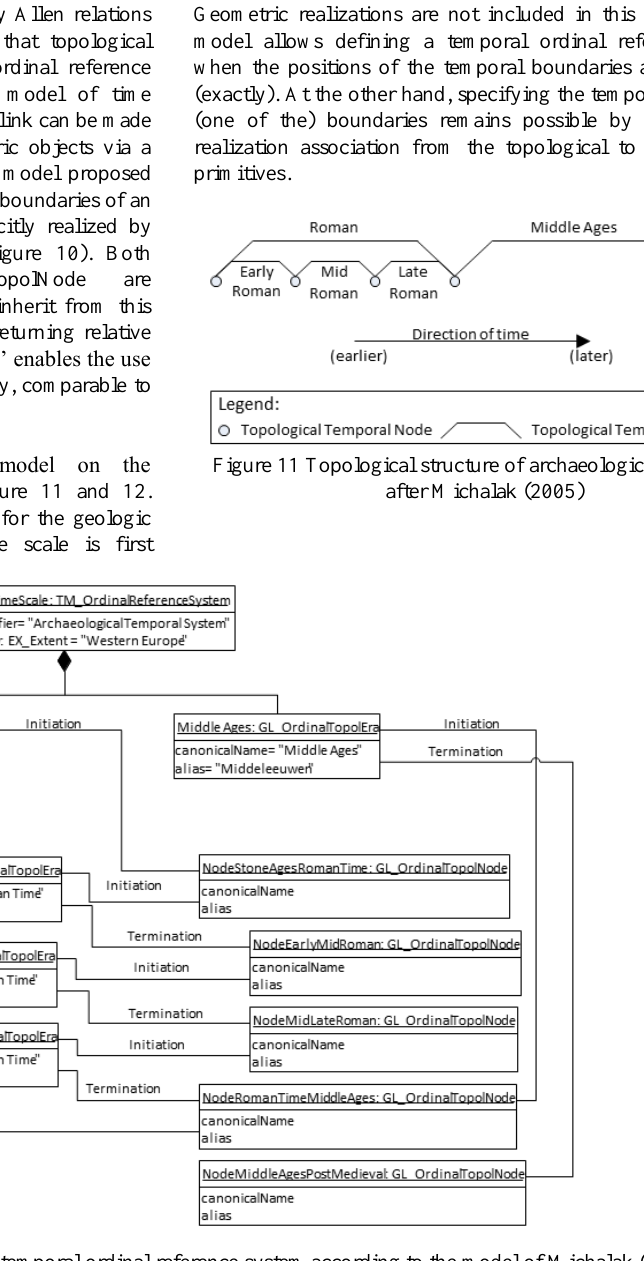
Figure 10 Conceptual model of topological ordinal reference system for geological application based on elements defined in